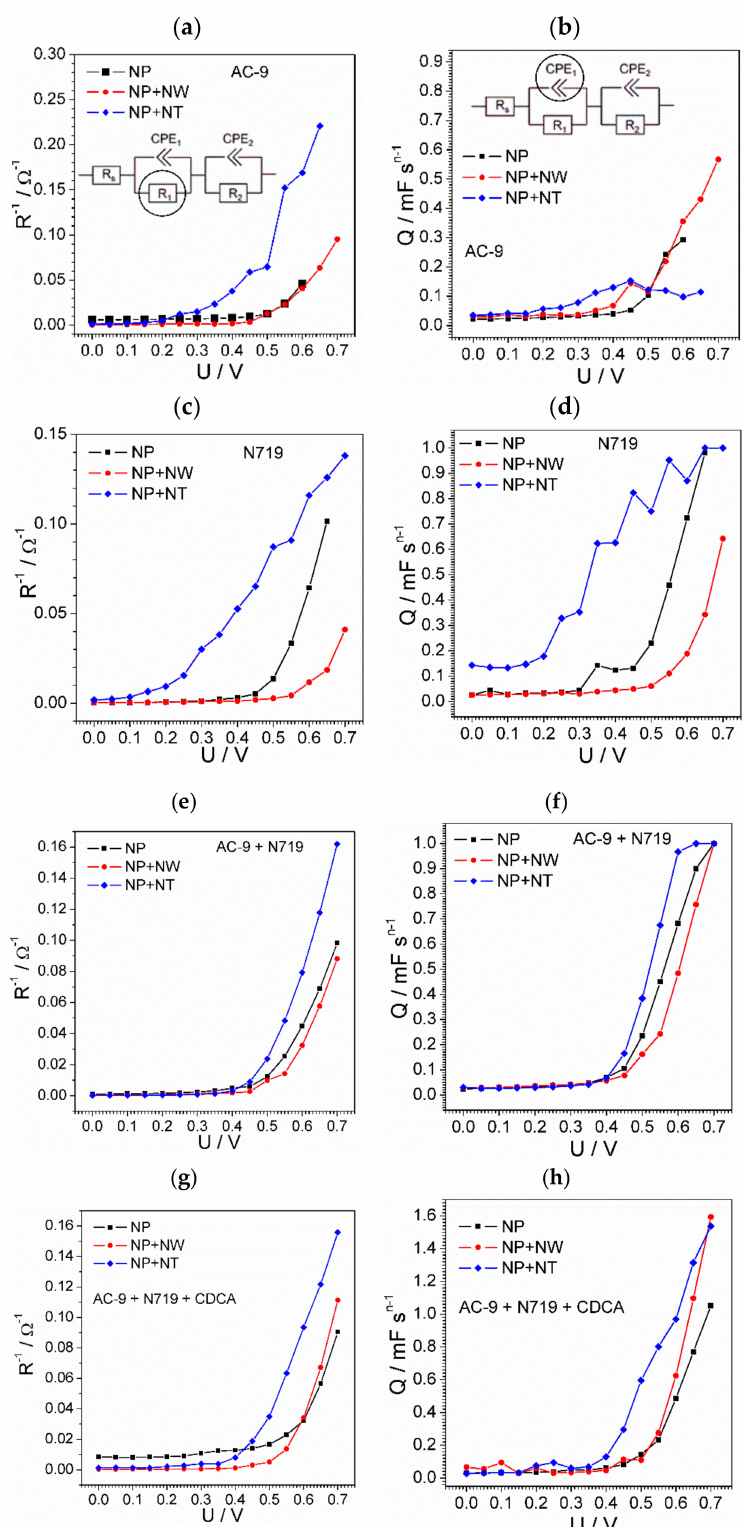
Figure 6. Dependence of TiO 2 -dye electrode resistance ( a , c , e , g ) and capacitance ( b , d , f , h ) on solar cell operating voltage. The results attributed to different TiO 2 forms are shown by different colors and specified in